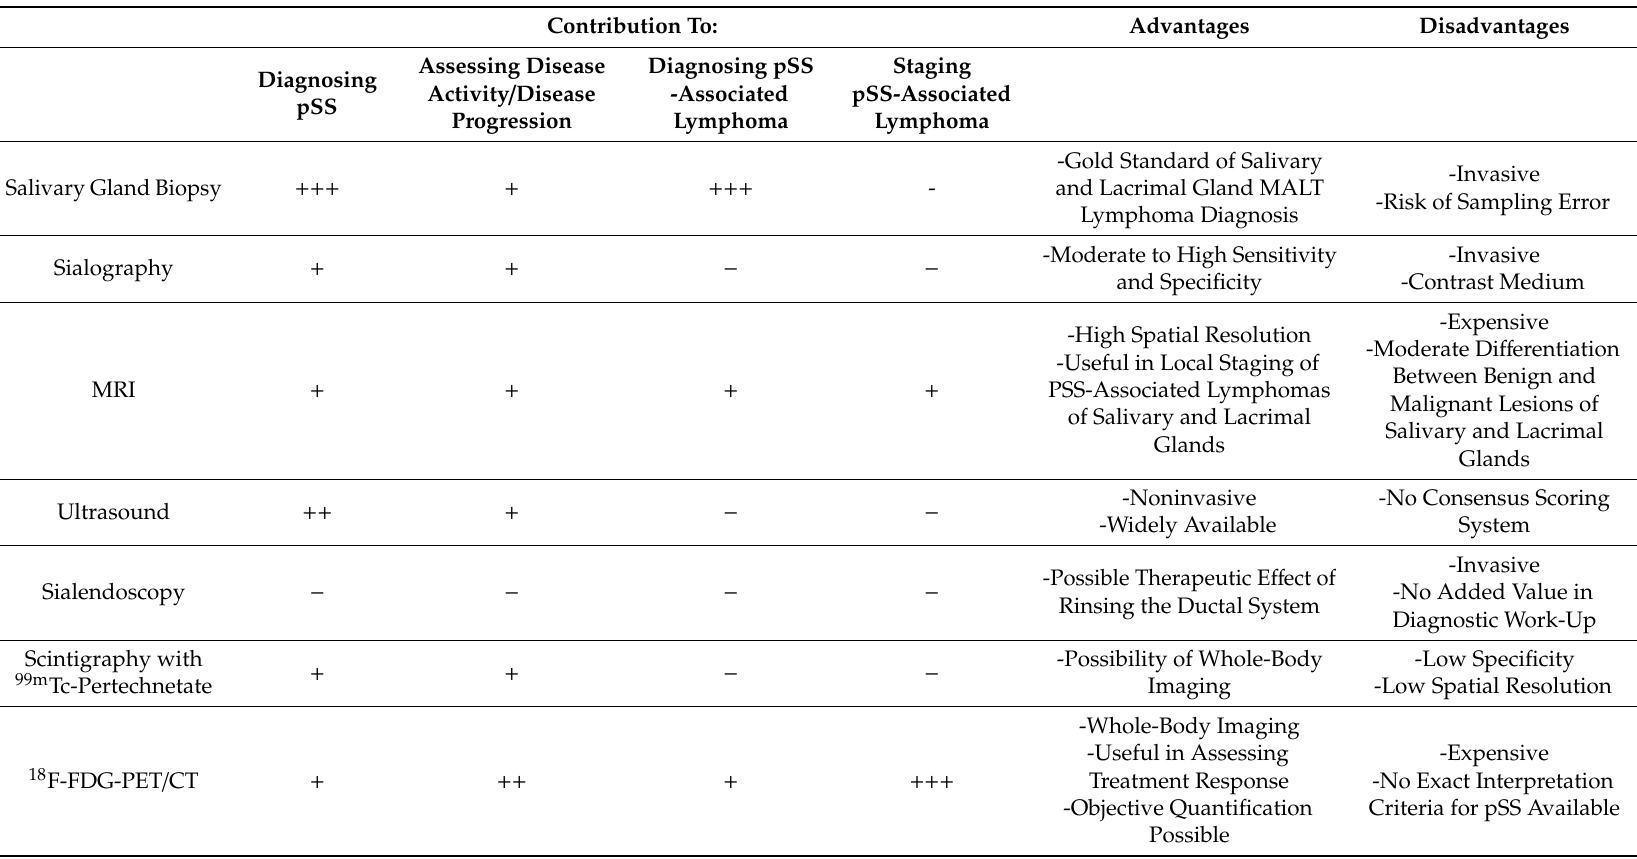
Table 2. Contribution of imaging techniques to the diagnostic work-up and follow-up of pSS patients. Contribution